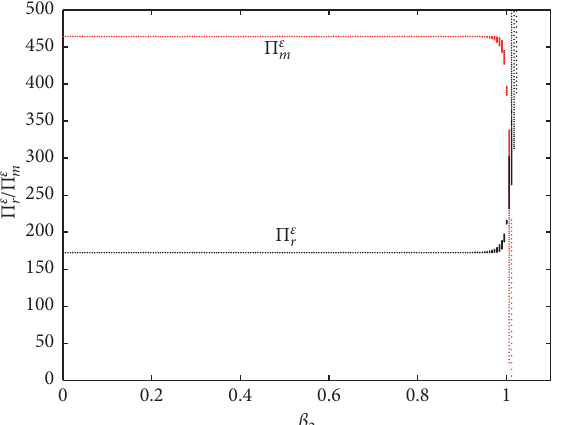
Figure 32: The bifurcation diagram of 􏽑